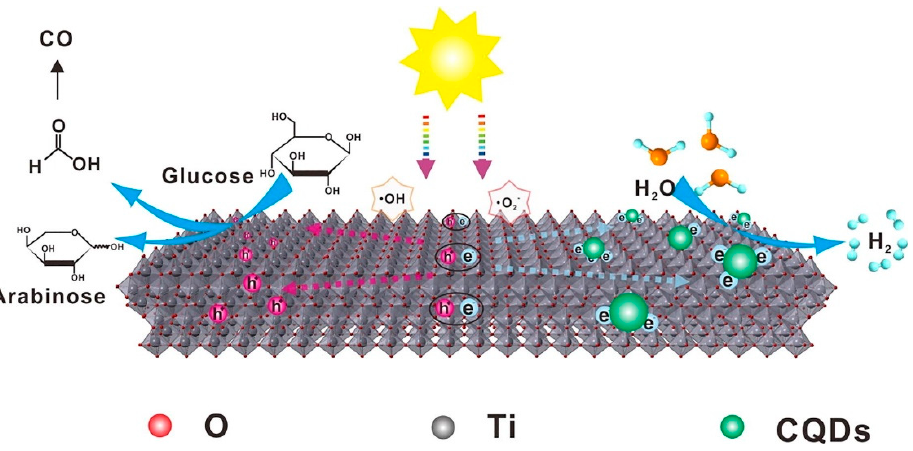
Figure 11. Proposed reaction mechanism for glucose photoreforming (reprinted with permission from [151], 2022, Elsevier).